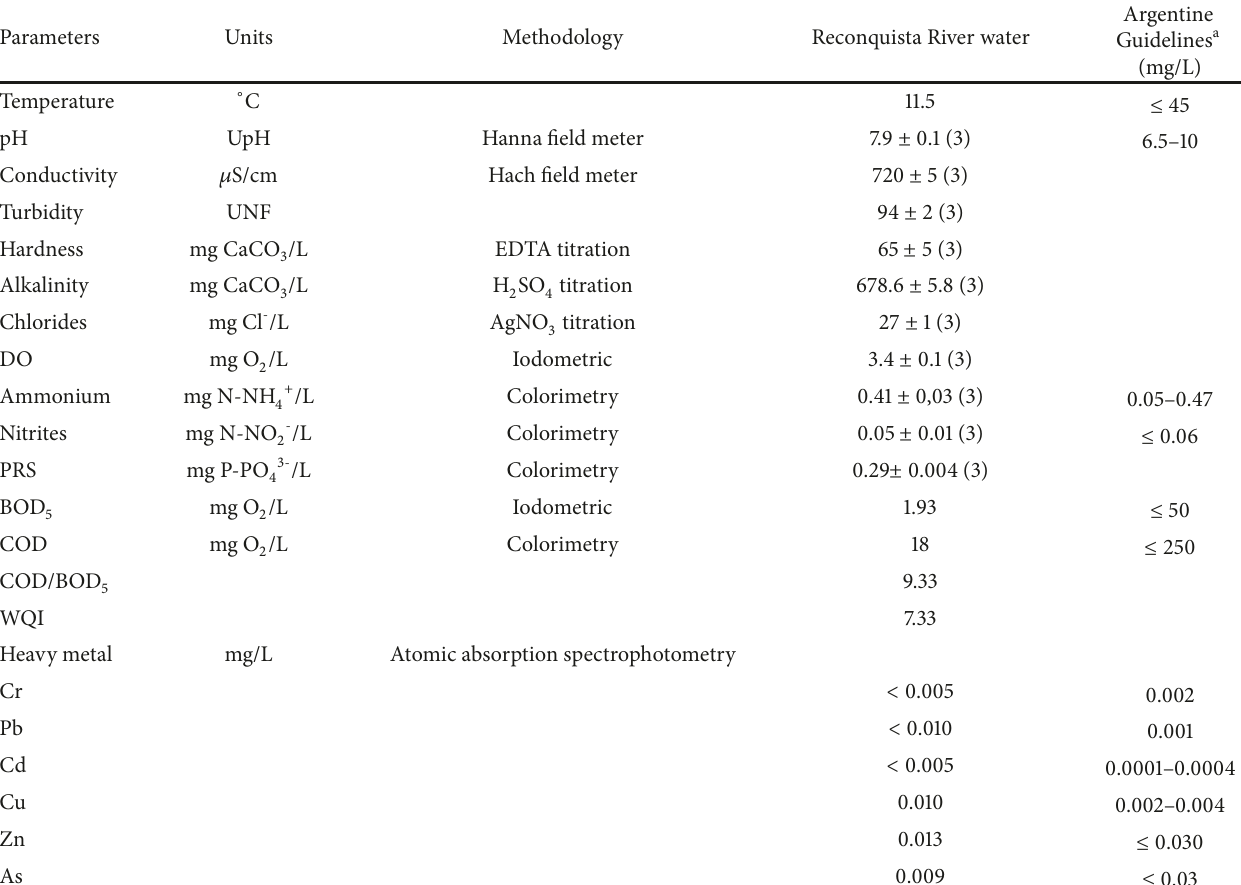
Table 1: Physicochemical parameters and water quality index (WQI) of the water sampled at the Reconquista